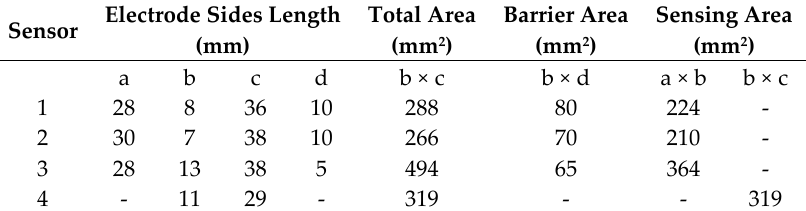
Table 2. PPy(Cl − ) electrodes’ sensing